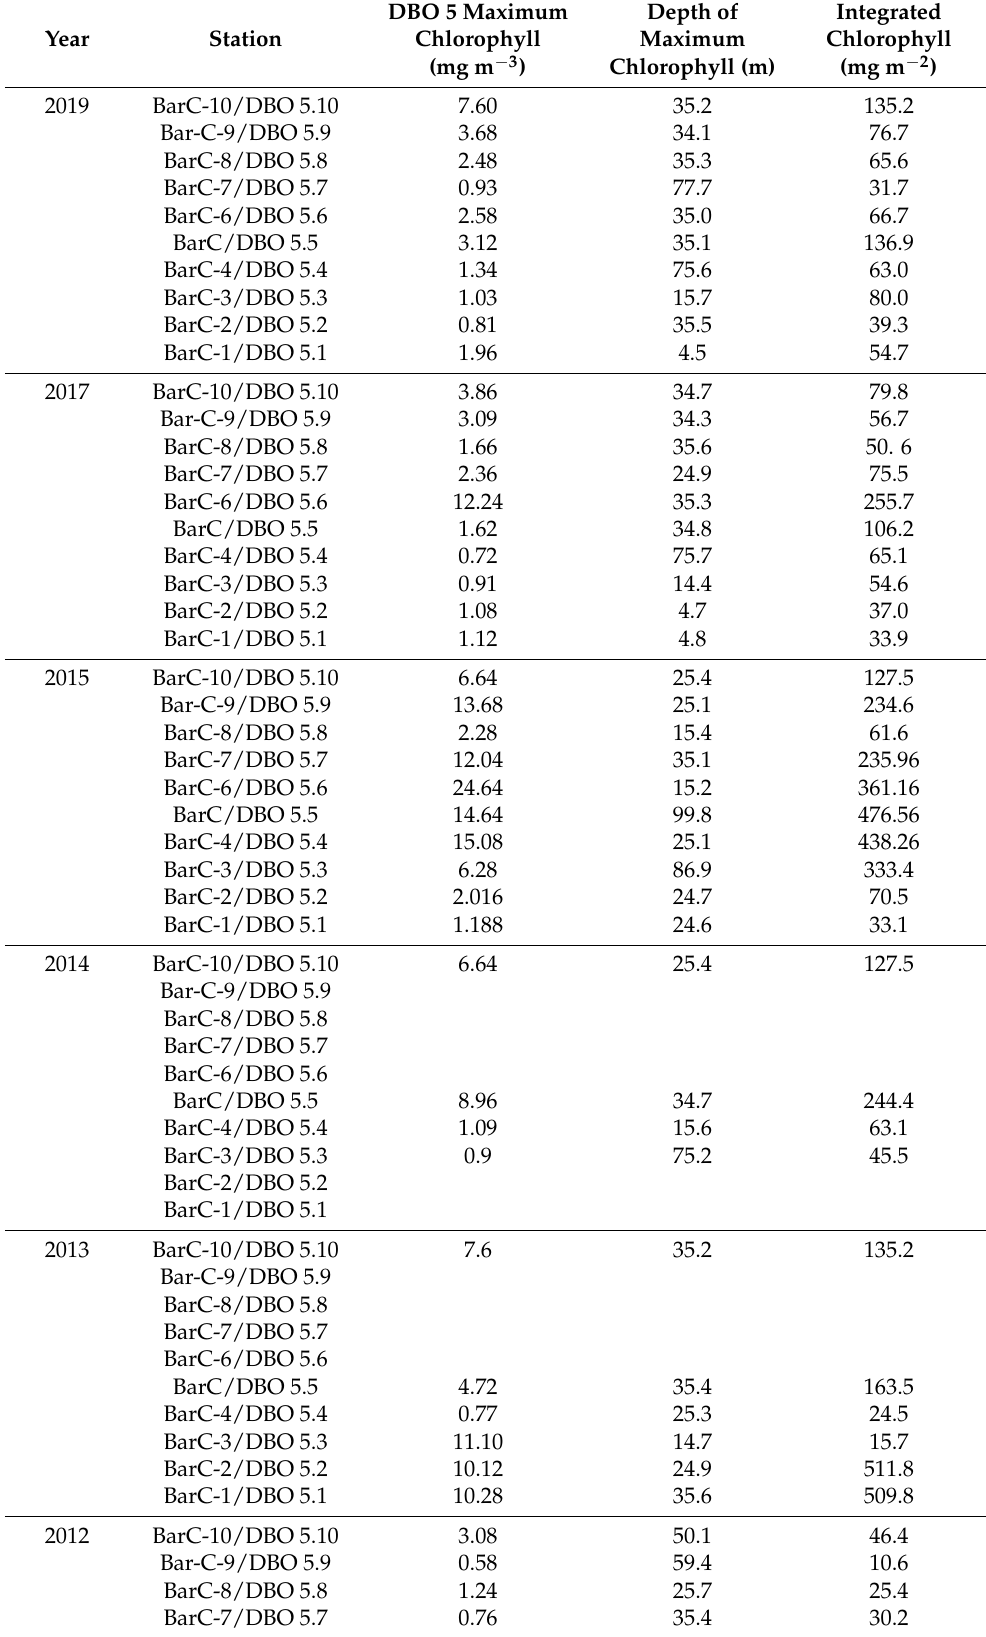
Table 5. DBO 5 Stations, Barrow Canyon area, 6-year time series for